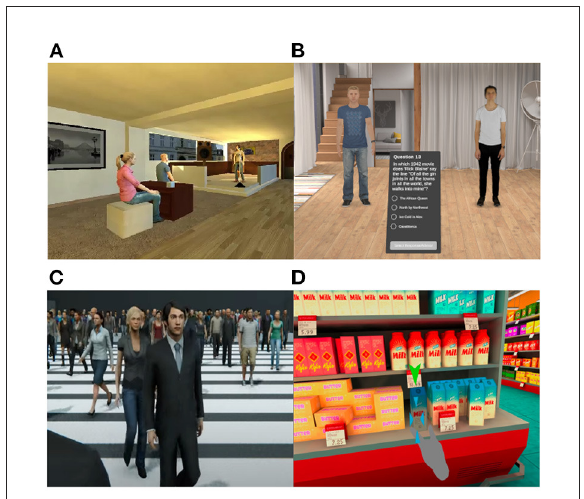
FIGURE1 Images from four of our recent experiments. (A) Our first in the wild study, where the participants watched a singer perform in a bar environment. (B) A VR environment simulating a potential AR conferencing situation. (C) An experiment on virtual crowds. (D) An experiment on seated vs. standing